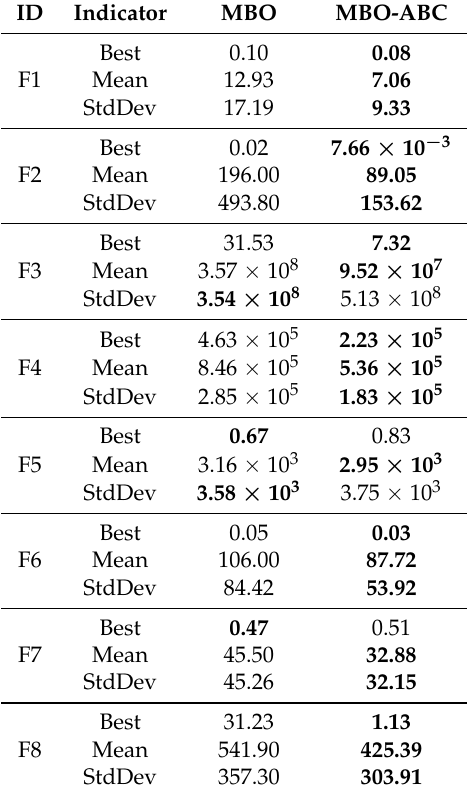
Table 3. Comparative analysis—hybridized MBO-ABC vs. original MBO on benchmarks with dimension D = 30 (bold style is used to indicate better results).